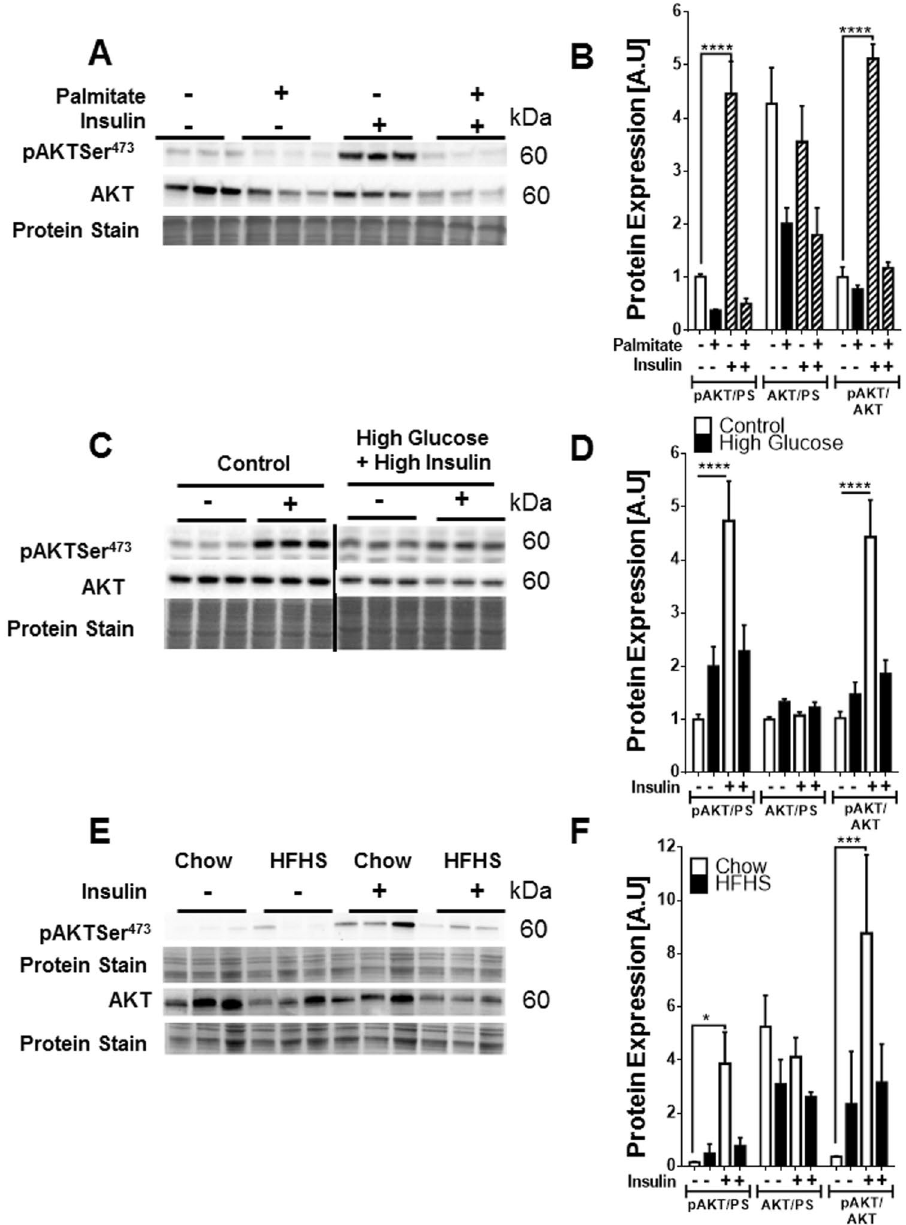
Figure 1. Assessment of insulin resistance in C2C12 cells, 3T3-L1 adipocytes, and AMCMs. Immunoblot and densitometric analysis of protein expression of AKT and insulin-stimulated AKT phosphorylation at Ser 473 in ( A,B ) C2C12 cells incubated in the absence or presence of 0.75 mM palmitate, ( C,D ) 3T3-L1 adipocytes incubated with media containing 6 mM glucose and no insulin (control) or 25 mM glucose and 100 nM insulin (high glucose + high insulin) for 24 h, ( E,F ) AMCMs obtained from chow and HFHS-fed mice ** p < 0.01, *** p < 0.001, **** p < 0.0001; A.U., arbitrary units; PS, protein